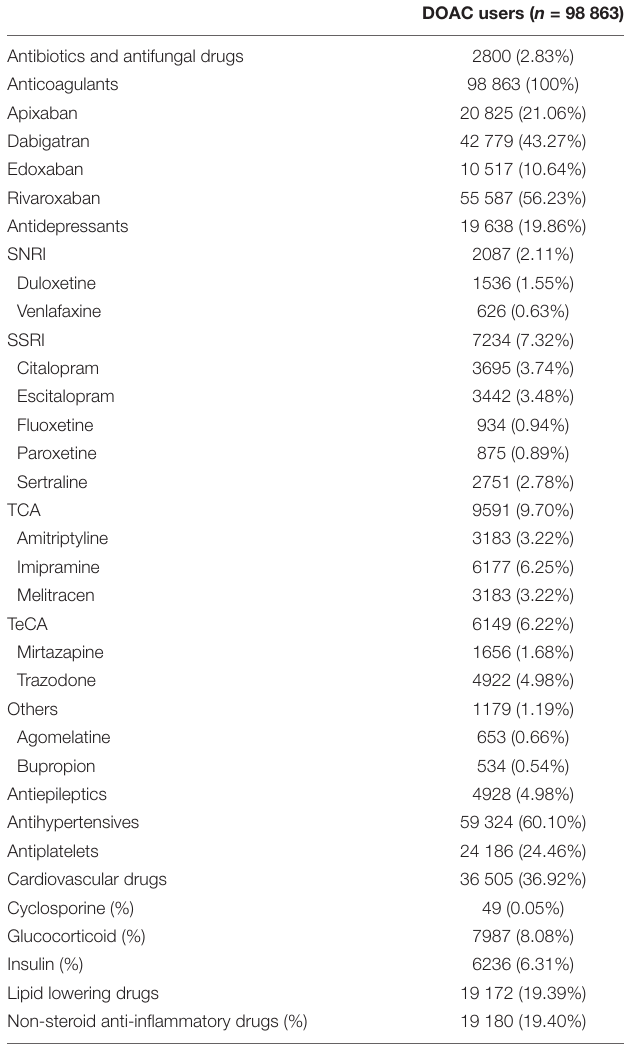
TABLE 2 | Medications during follow-up.